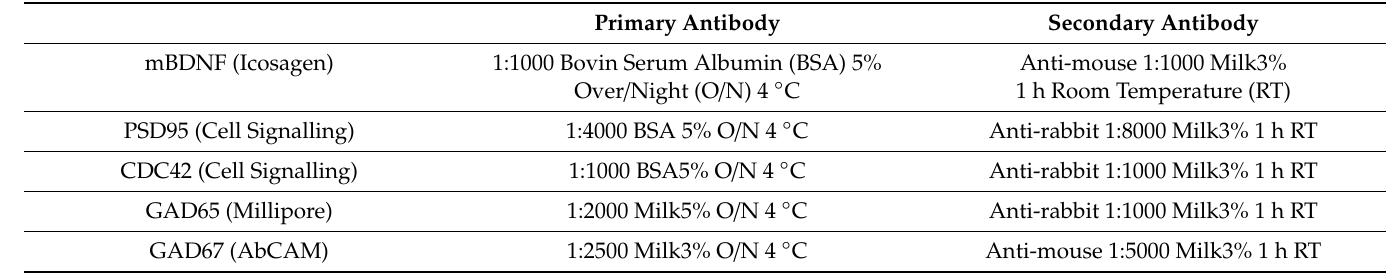
Table 2. Antibodies condition used in the western blot